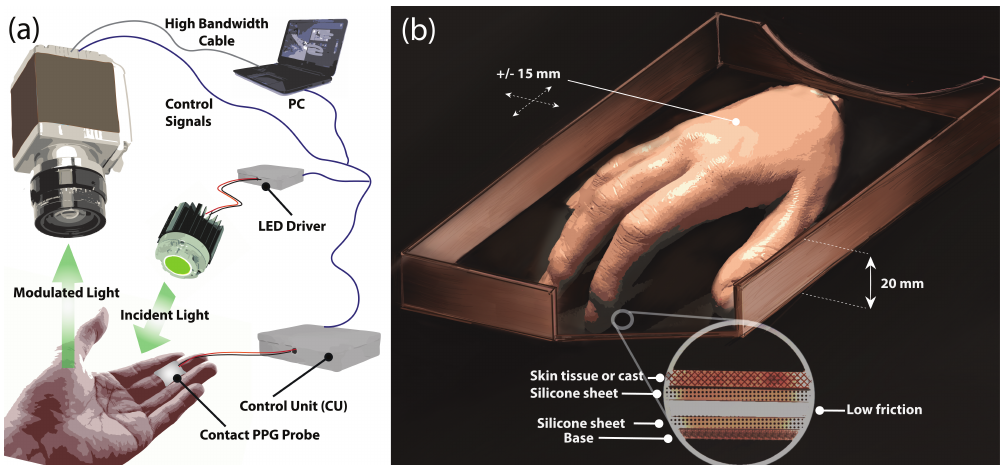
Figure 4. ( a ) Hardware setup for data acquisition. The control module (CU) is responsible for activating LEDs and triggering camera frame exposure using control signals. The intensity of LED assembly can be tuned via the CU. Parameters are set and monitored on a PC using a custom graphical interface. ( b ) The experimental setup showing the composition of the silicone sheets allowing the palm to slide freely in any direction within ± 15